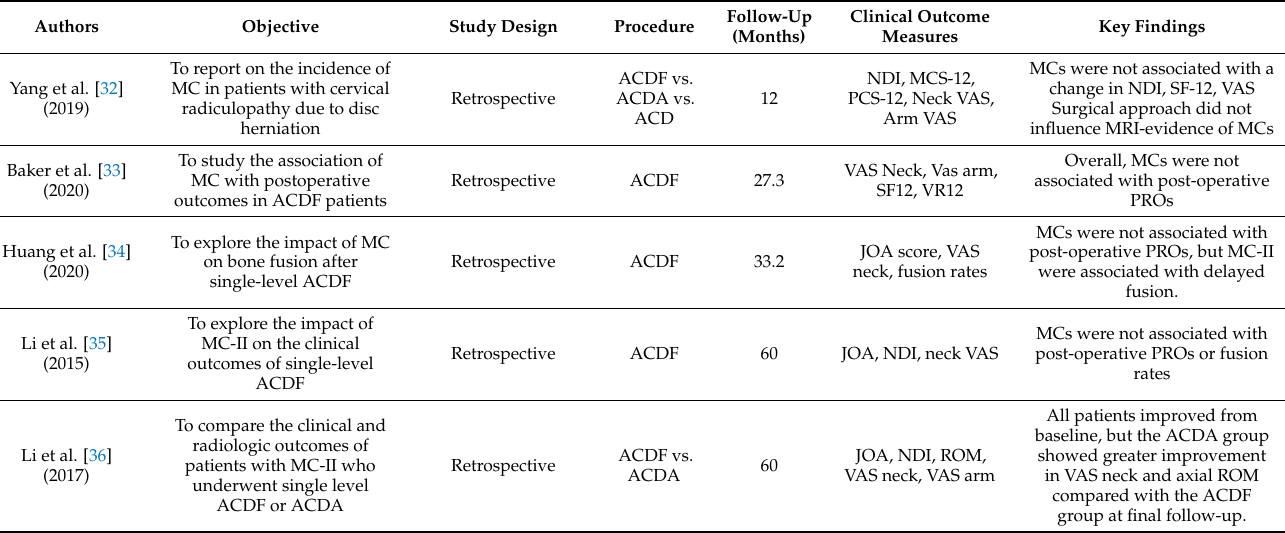
Table 3. The key findings of surgery in patients with cervical Modic